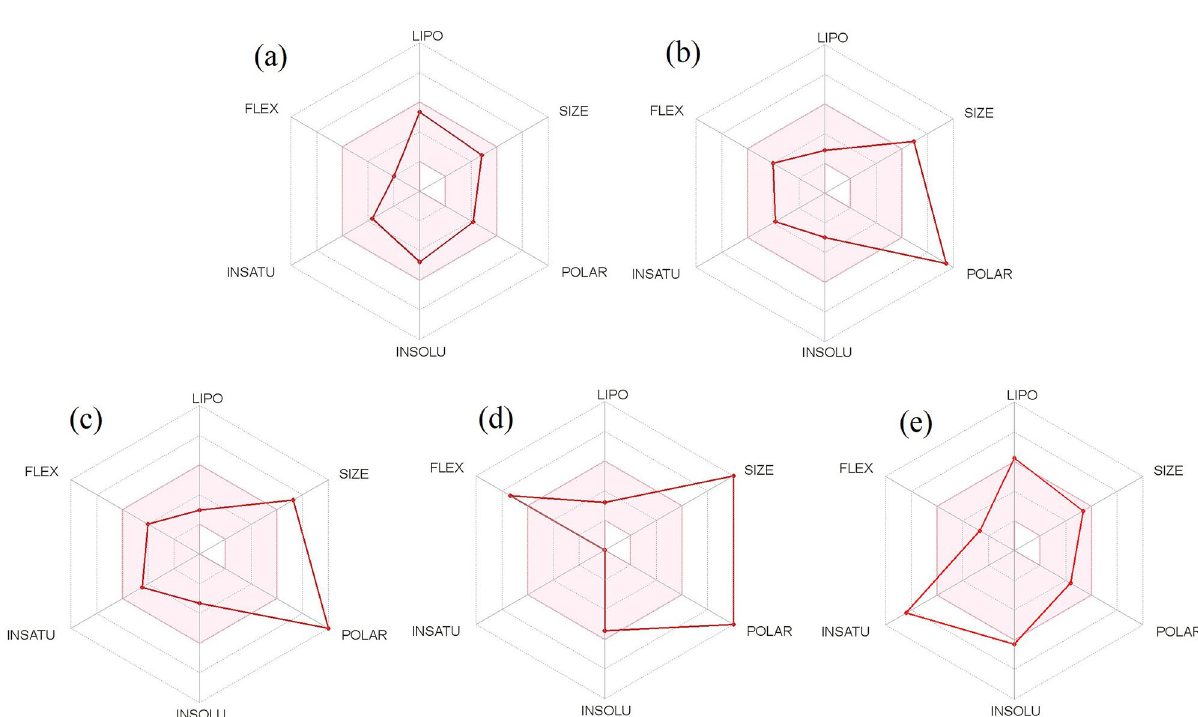
Figure 9. Bioavailability radar plot for oral bioavailability of selected bioactive compounds. CID: 12041593 (ASA) ( a ), CID: 442428 (NAR) ( b ), CID: 5280805 (RUT) ( c ), CID: 28523 (TOM) ( d ) and CID: 447077 standard MAPK6 inhibitor drug ( e ). The pink area exhibits the optimal range for each properties (Lipophilicity as XLOGP3 between − 0.7 and + 5.0; Size as molecular weight between 150 and 500 g mol −1 ; Polarity as TPSA (topological polar surface area) between 20 and 130 Å 2 ; Insolubility in water by log S scale not higher than 6; Insaturation as per fraction of carbons in the sp3 hybridization not less than 0.25 and Flexibility as per rotatable bonds no more than